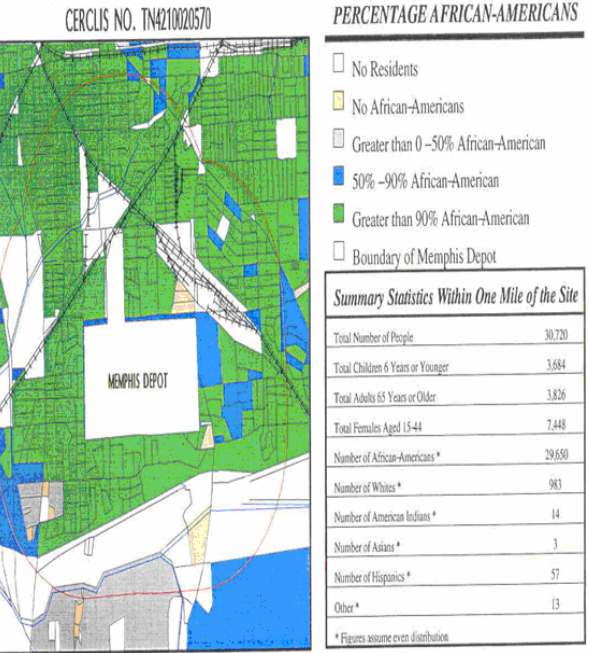
Figure 2: Demographics of DDMT Residential